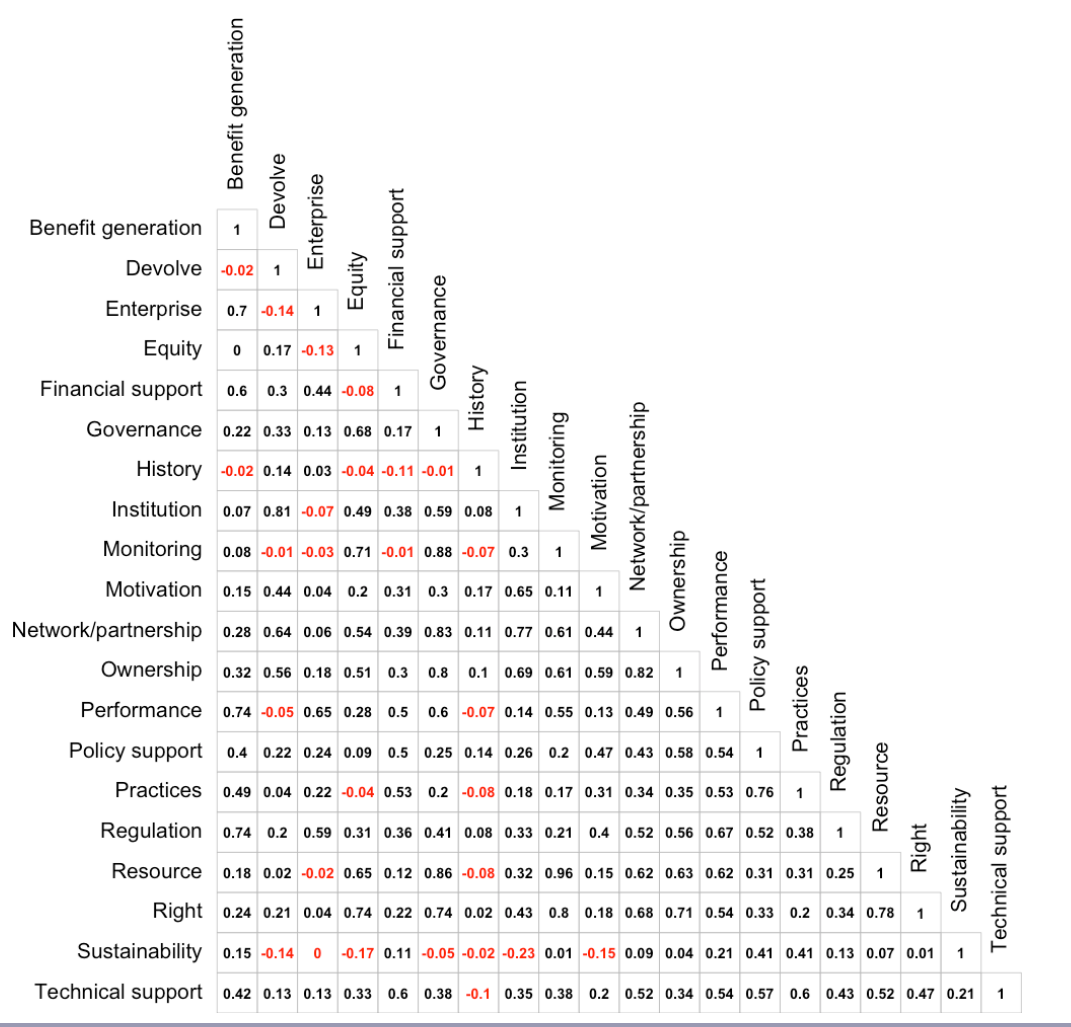
Fig. 4 . The correlation matrix showing co-occurrences of enablers in the examined